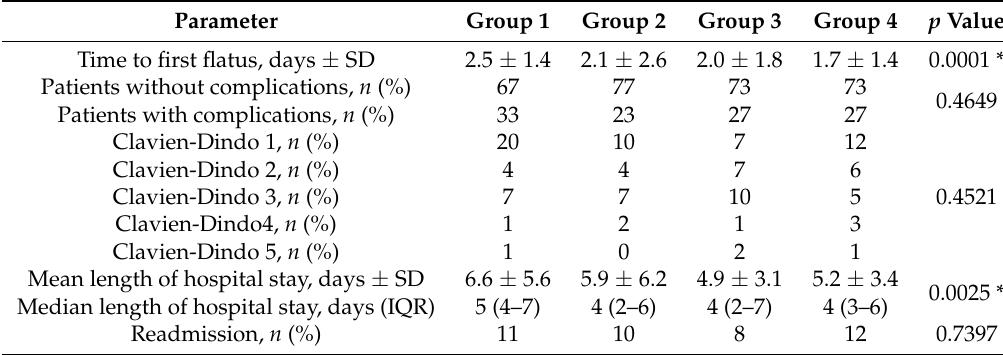
Table 3. Postoperative outcomes in analysed